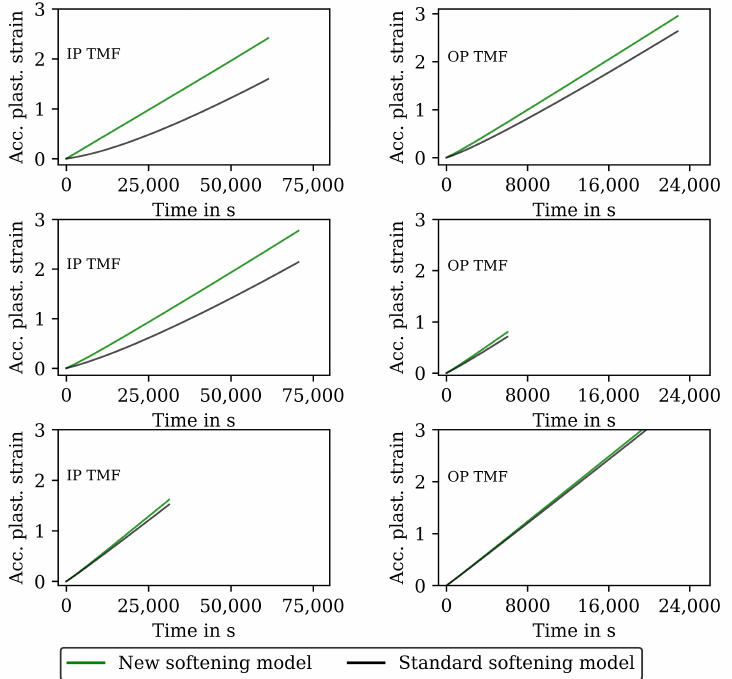
Figure 14. Accumulated plastic strain calculated with the new cyclic-softening model ( left ) and the standard isotropic-softening model ( right ) for the in-phase and out-of-phase TMF tests for the HT0